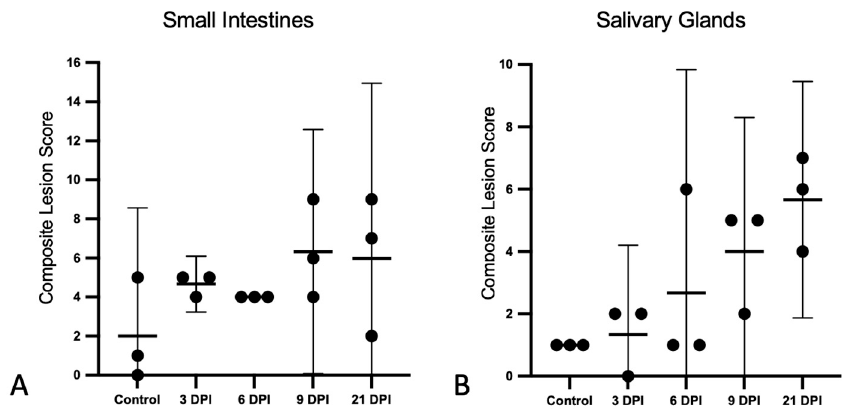
Figure 3. Histopathologic lesion scores in the small intestines and salivary glands of SOSV-infected Egyptian rousette bats. Individual groups are represented on the x axis and each dot represents the score for a single bat. Bars represent the mean and lines represent the ± 95% confidence interval. Control bats were euthanized at 21 DPI. ( A ) Criteria used to generate a composite small intestine lesion score for each bat included: villus epithelial discontinuity or ulceration, accumulation of eosinophilic fluid in the lamina propria, hypercellularity of the lamina propria, epithelial cell apoptosis and/or tingible body macrophages in the lamina propria and villus fusion. ( B ) Salivary gland scores were positively correlated with time. Criteria used to generate a composite salivary gland lesion score for each bat included: sialodochitis, sialadenitis, duct epithelial cell apoptosis and epithelial